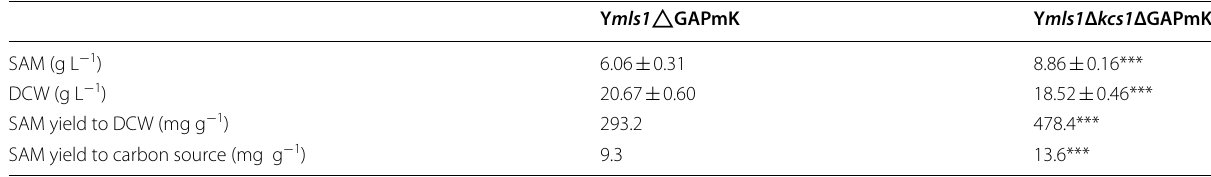
The symbol *** denotes significant diferences between the recombinant strain and the wild strain, with p < 0.001